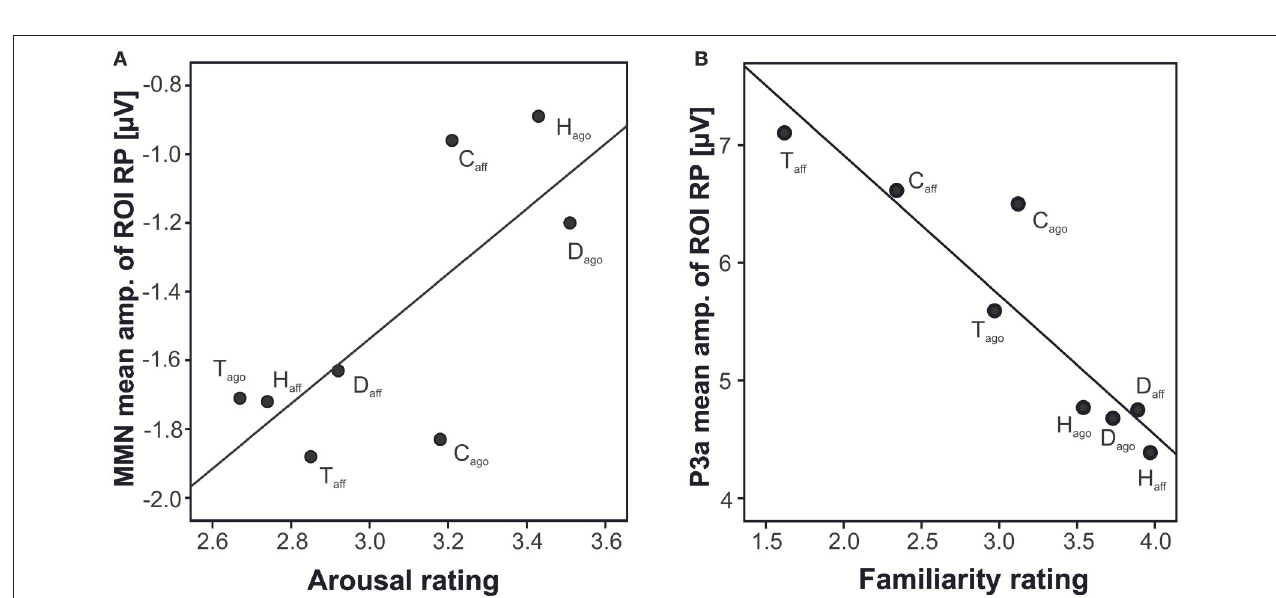
FIGURE 2 | Mean and standard deviations of the ERP amplitudes to agonistic and affiliative vocalizations by species at the anterior and posterior ROIs (pooled for both hemispheres); black square, agonistic vocalizations; white square, affiliative vocalizations.